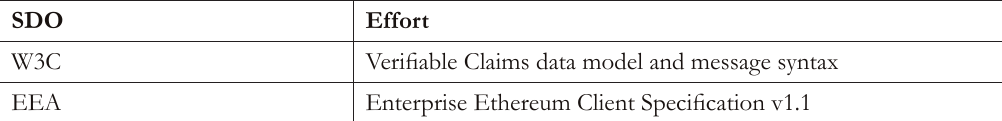
Table 3. Current Standardisation Efforts